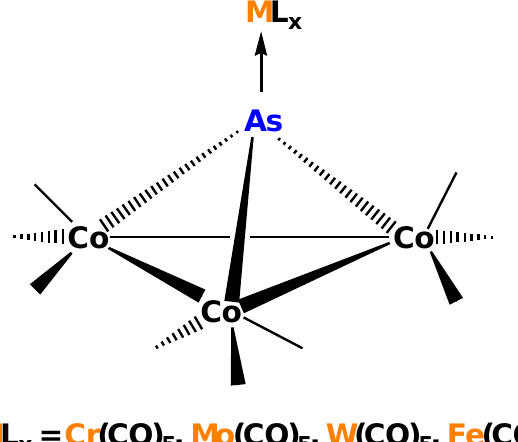
Figure 15. Schematic view of the structures of complexes 23 (M = Cr, Mo, W) and of complex 24 [71]. Catalysts 2018 , 8 , x FOR PEER REVIEW